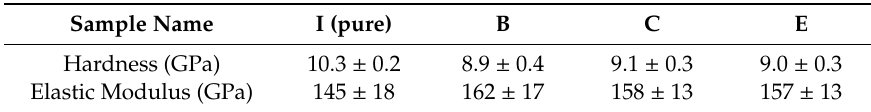
Table 4. Hardness and elastic modulus values of electrodeposited pure Sn–Ni (I) and Sn–Ni / TiO 2 composite coatings (B,C,E) 1